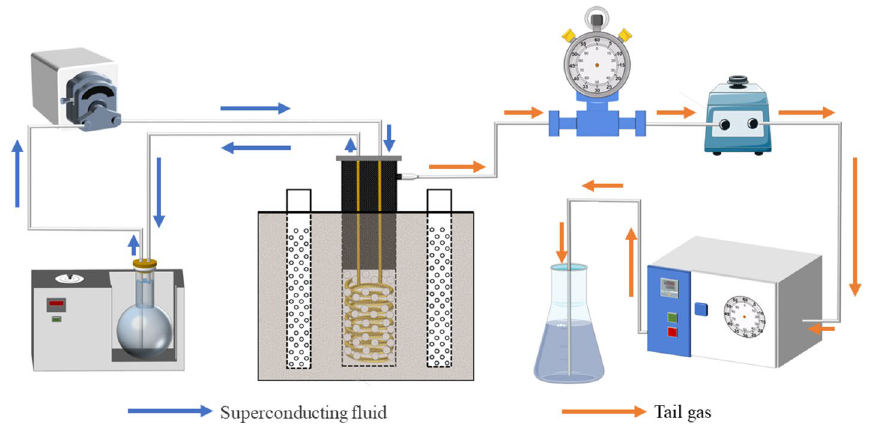
Figure 1. Design of the TOSVE system.